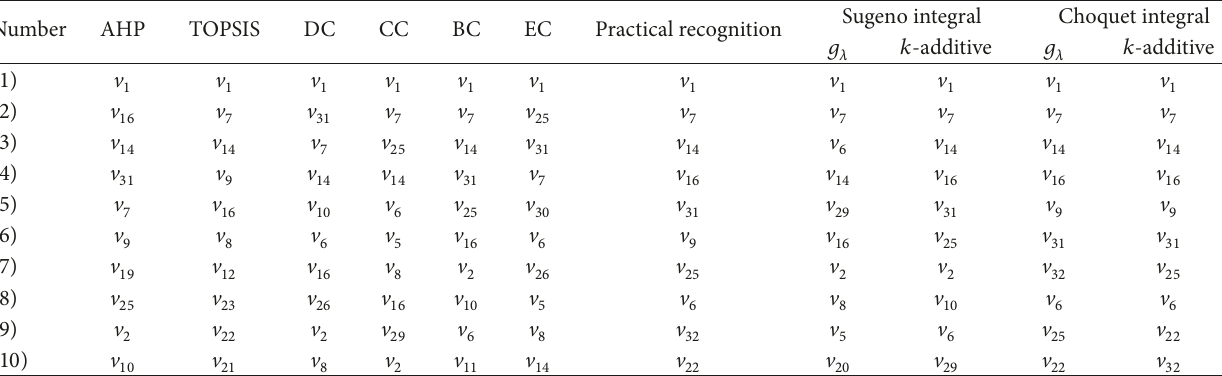
Table 5: The evaluation results of different